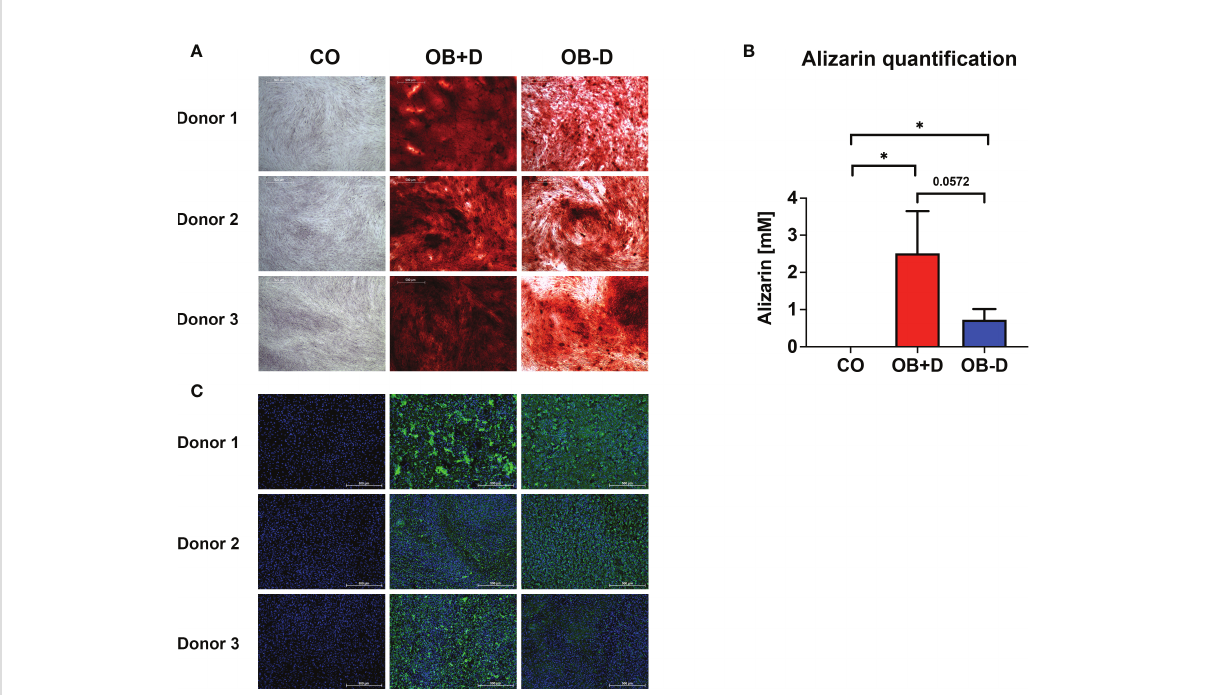
FIGURE 1 Mineralization capacity of JPCs from used donors. JPCs (3 donors) were cultured with control medium (CO), osteogenic medium with (OB+D) and without dexamethasone (OB-D) for 15 days. (A) Calcium deposits were stained with alizarin red. (B) Quanti fi cation of alizarin staining. Data of three independent experiments are given as means ± SD and compared with each other using student ’ s t test (n=3, *p < 0.05). (C) Hydroxyapatite particles were stained using the fl uorescent OsteoImage assay (green) and cell nuclei were stained with Hoechst (blue). Scale bars represent 500